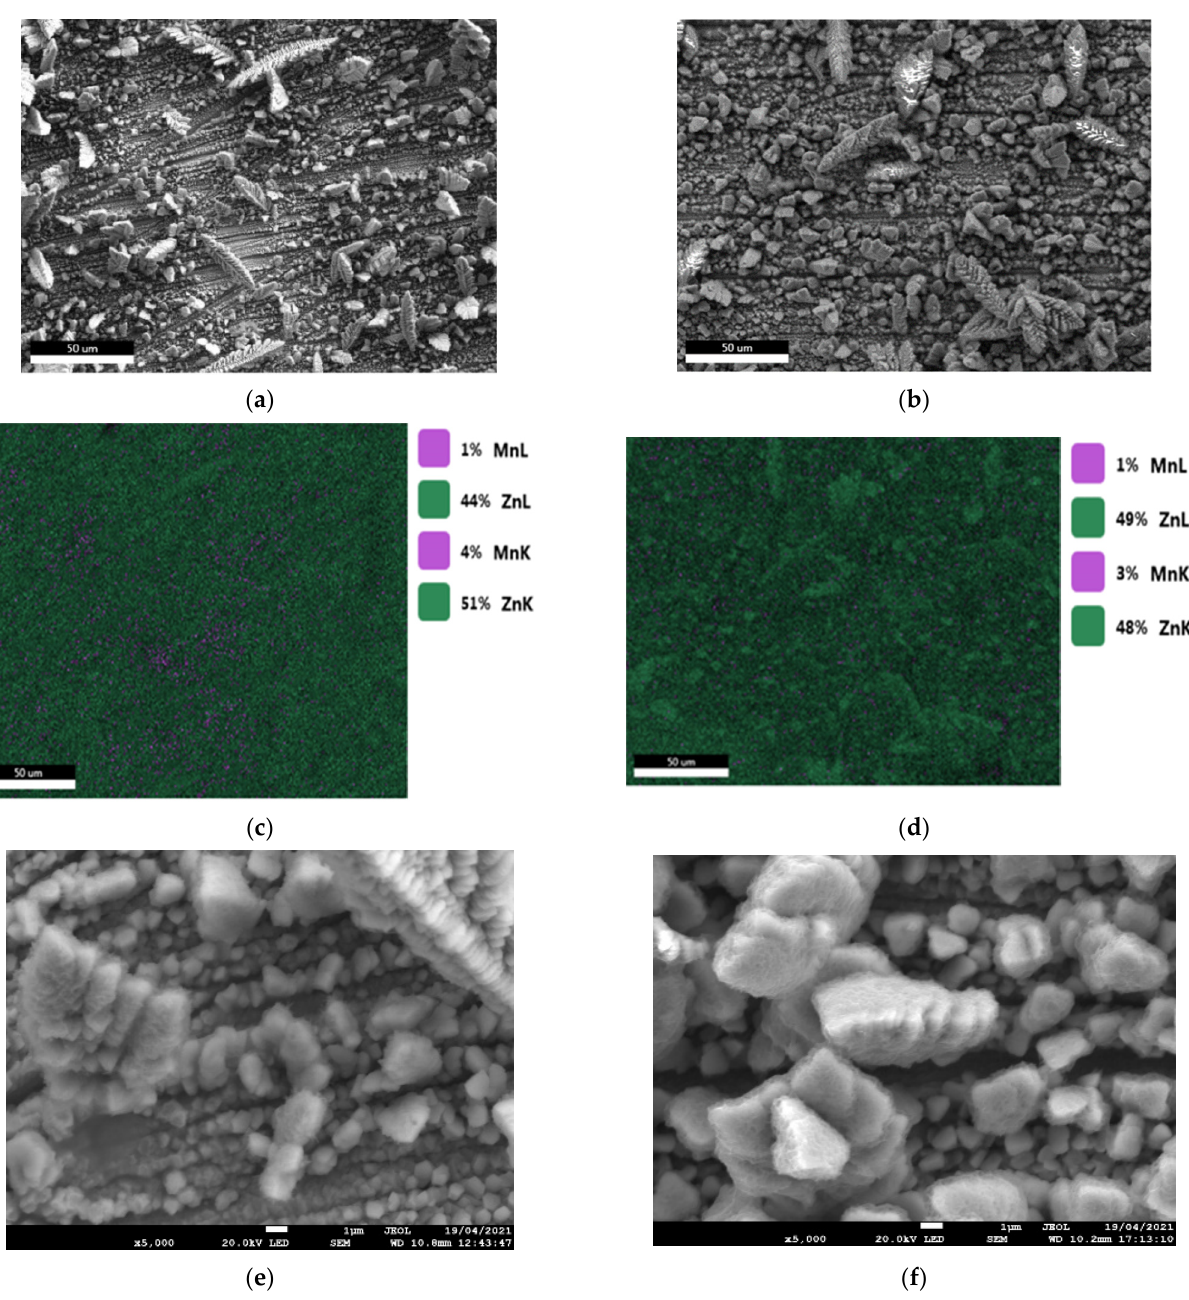
Figure 10. Morphologies of coatings elaborated for B = 0 T and for E = − 1.6 V/SCE, before immersion (( a ) imagex500, ( b ) mapping, and ( c ) imagex5000 and after immersion for 2 h in 35 g/L NaCl (( d ) imagex500, ( e ) mapping, and ( f ) imagex5000).